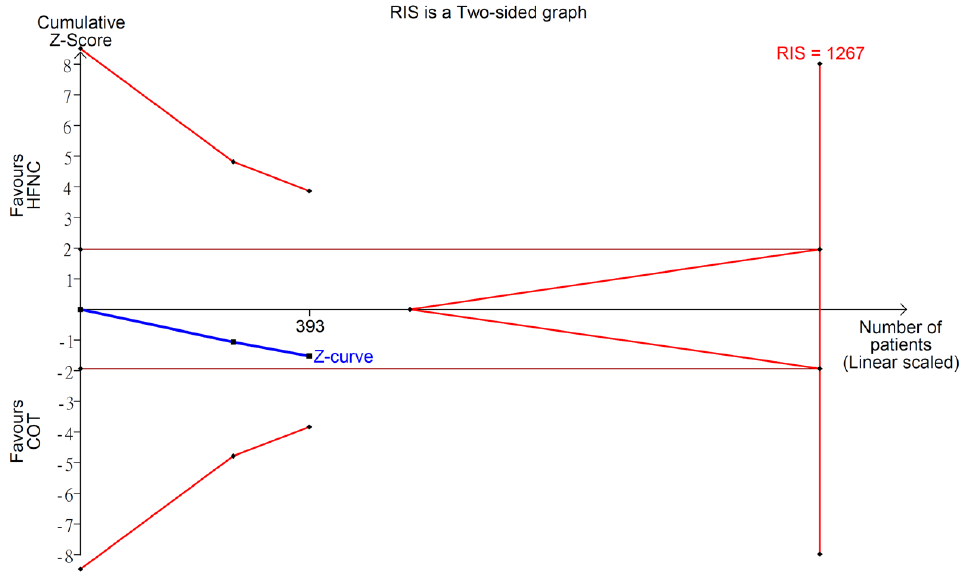
Figure A7. Trial sequential analysis: incidence of hypercapnia. All six studies.